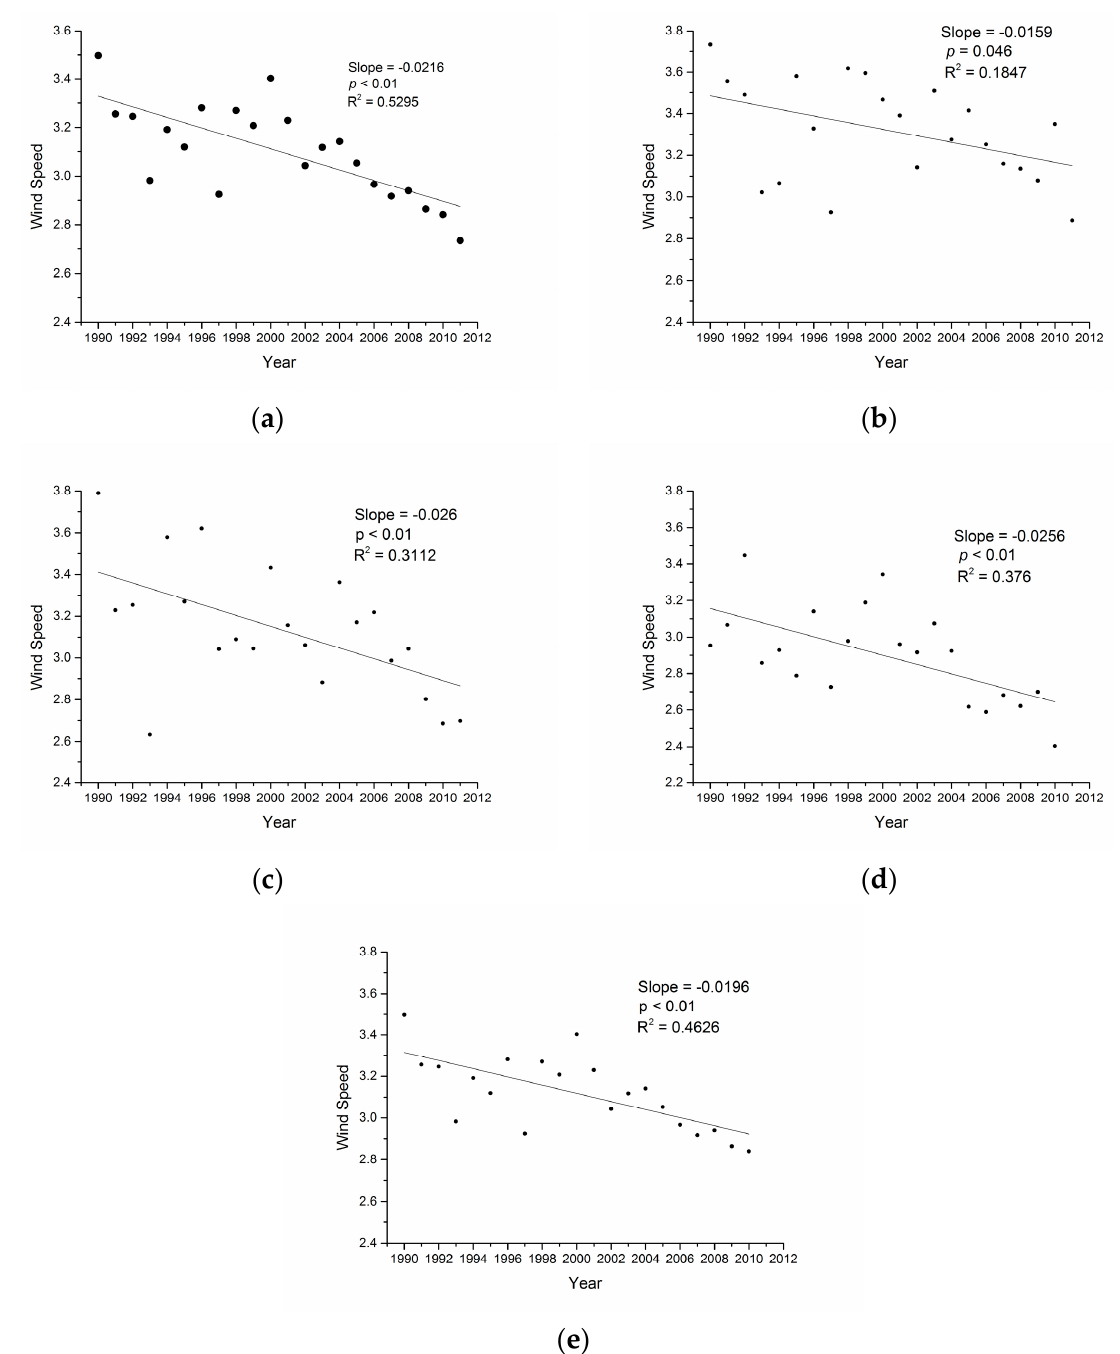
Figure 3. Plots showing the temporal trends of annual average wind speed, in m·s − 1 , from 1990–2011: ( a ) across year; ( b ) in spring; ( c ) in summer; ( d ) in fall; and ( e ) in winter.